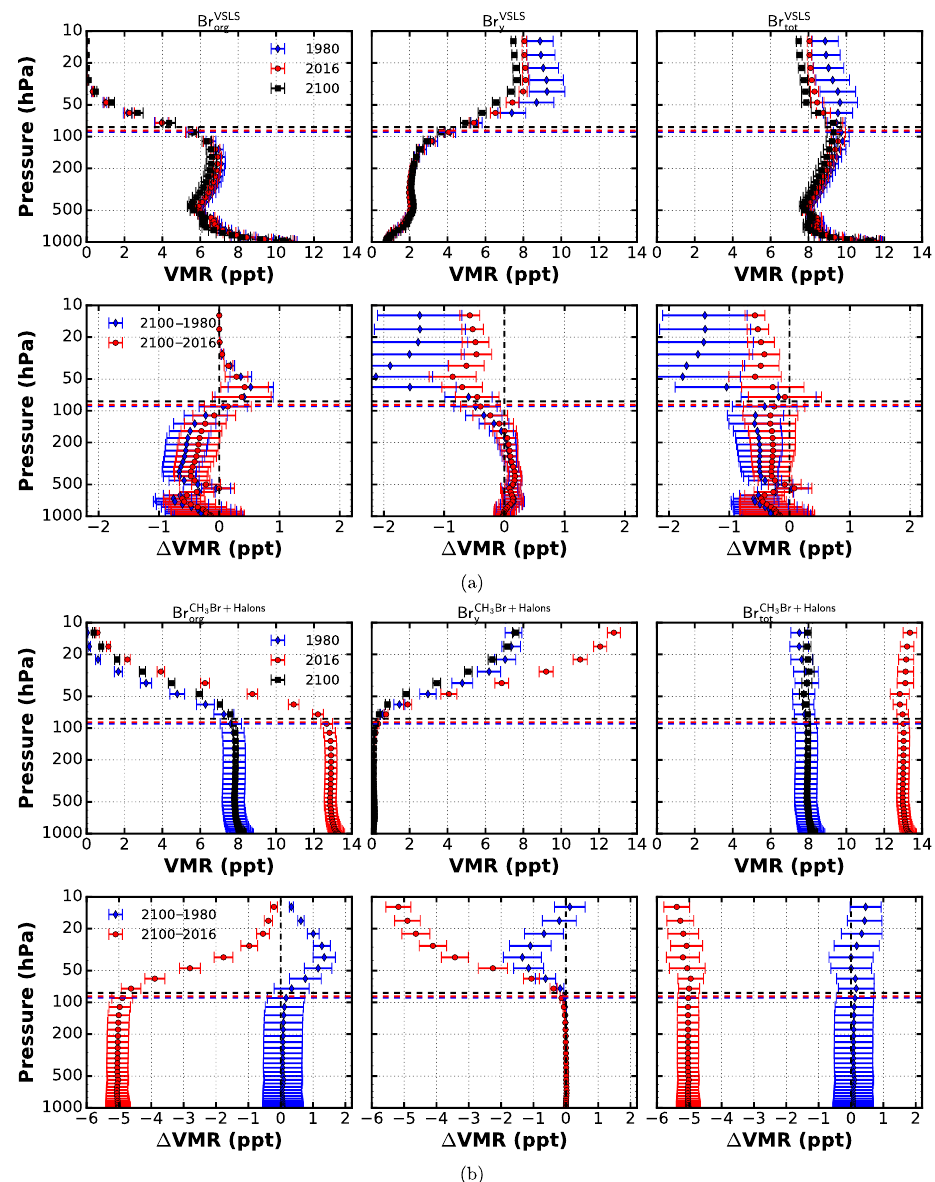
Figure 5. Vertical profiles of brominated substances divided into SG (Br org ), PG (Br y ), and SG + PG (Br tot ) in the tropics (20 ◦ N–20 ◦ S). Data from ESCiMo RC2-base-05 simulation (Jöckel et al., 2016). Absolute values of VMR in upper panel, difference (cid:49) VMR with respect to 2100 values in lower panel. (a) Bromine from VSLS; (b) bromine from CH 3 Br and halons.